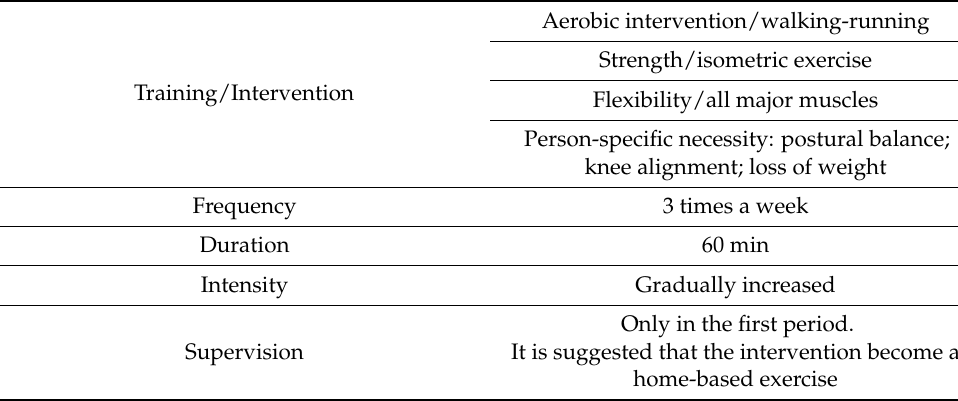
Table 4. Standard Operating Procedure proposal for an intervention for the cartilage wellness. Aerobic intervention/walking-running Strength/isometric exercise Training/Intervention Flexibility/all major muscles Person-specific necessity: postural